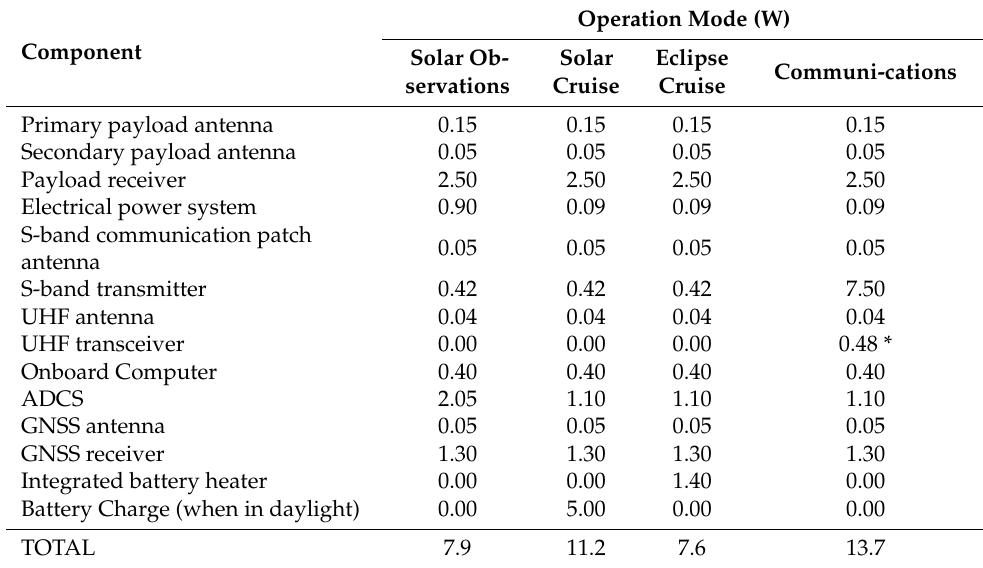
Table 10. Power budget for RMCSat. Power consumption for the UHF is for the receiver only. 4W are consumed during UHF transmission, but this value would replace S-band transmitter